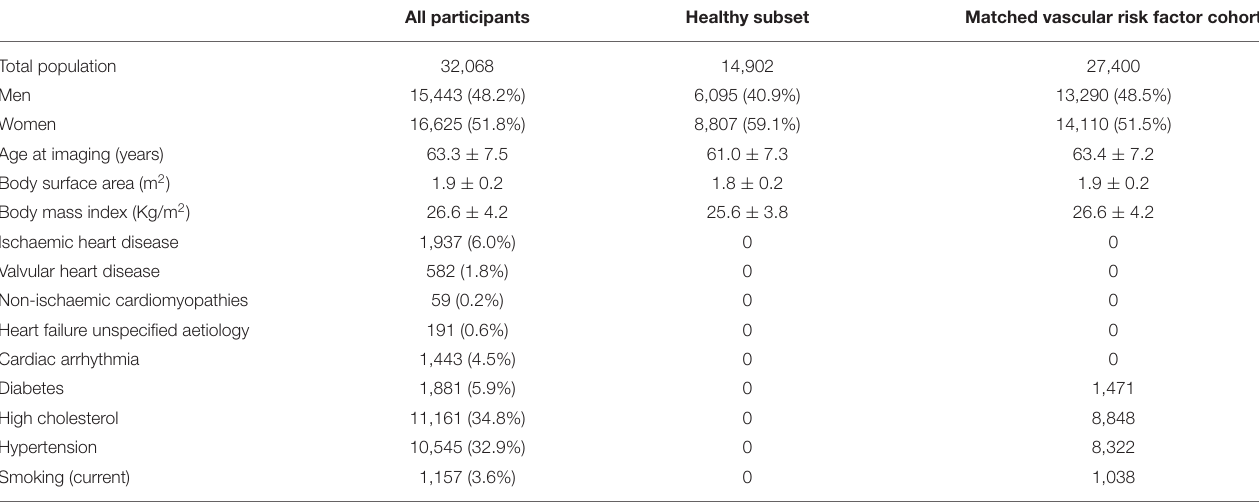
TABLE 2 | Baseline participant characteristics.